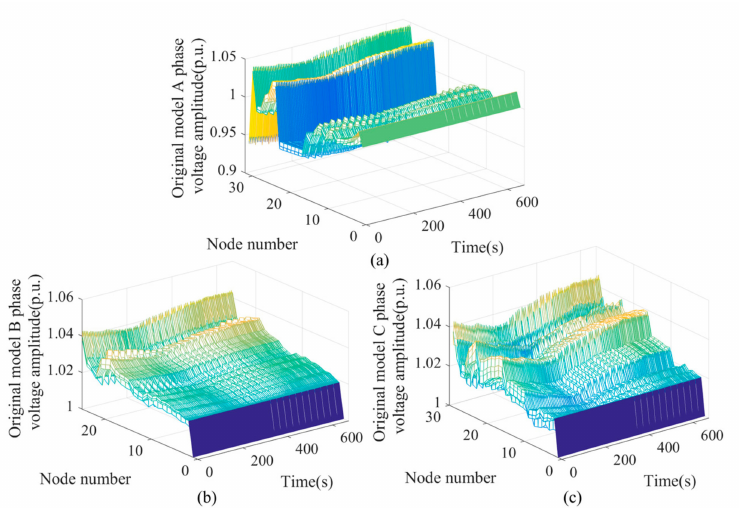
Figure 13. Three-phase voltage dynamic simulation using the original model.